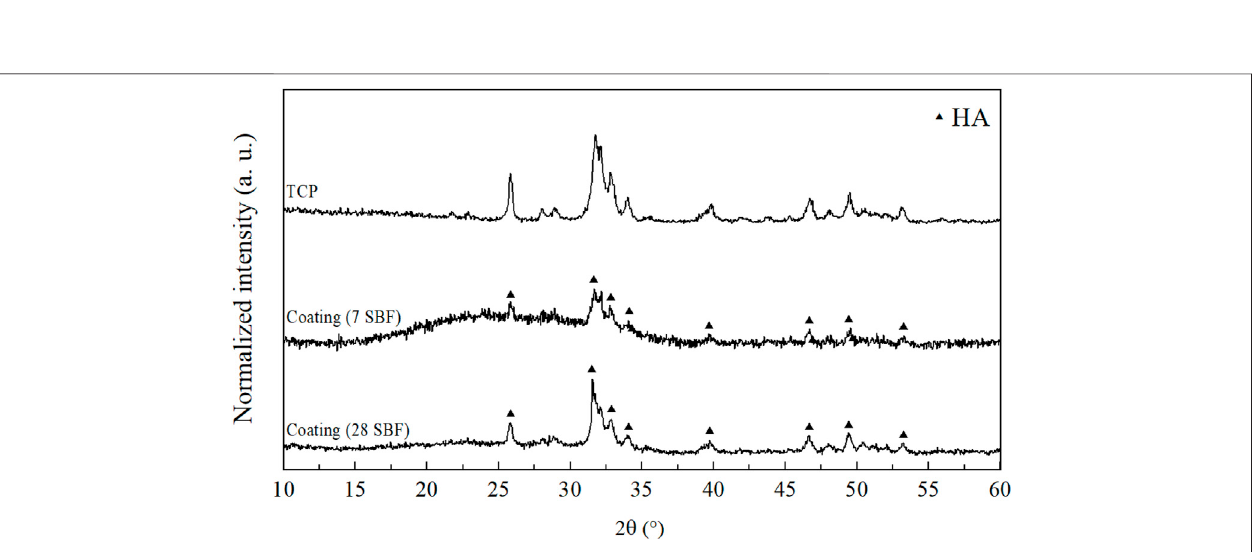
FIGURE 8 | XRD spectra of coatings after immersion in SBF